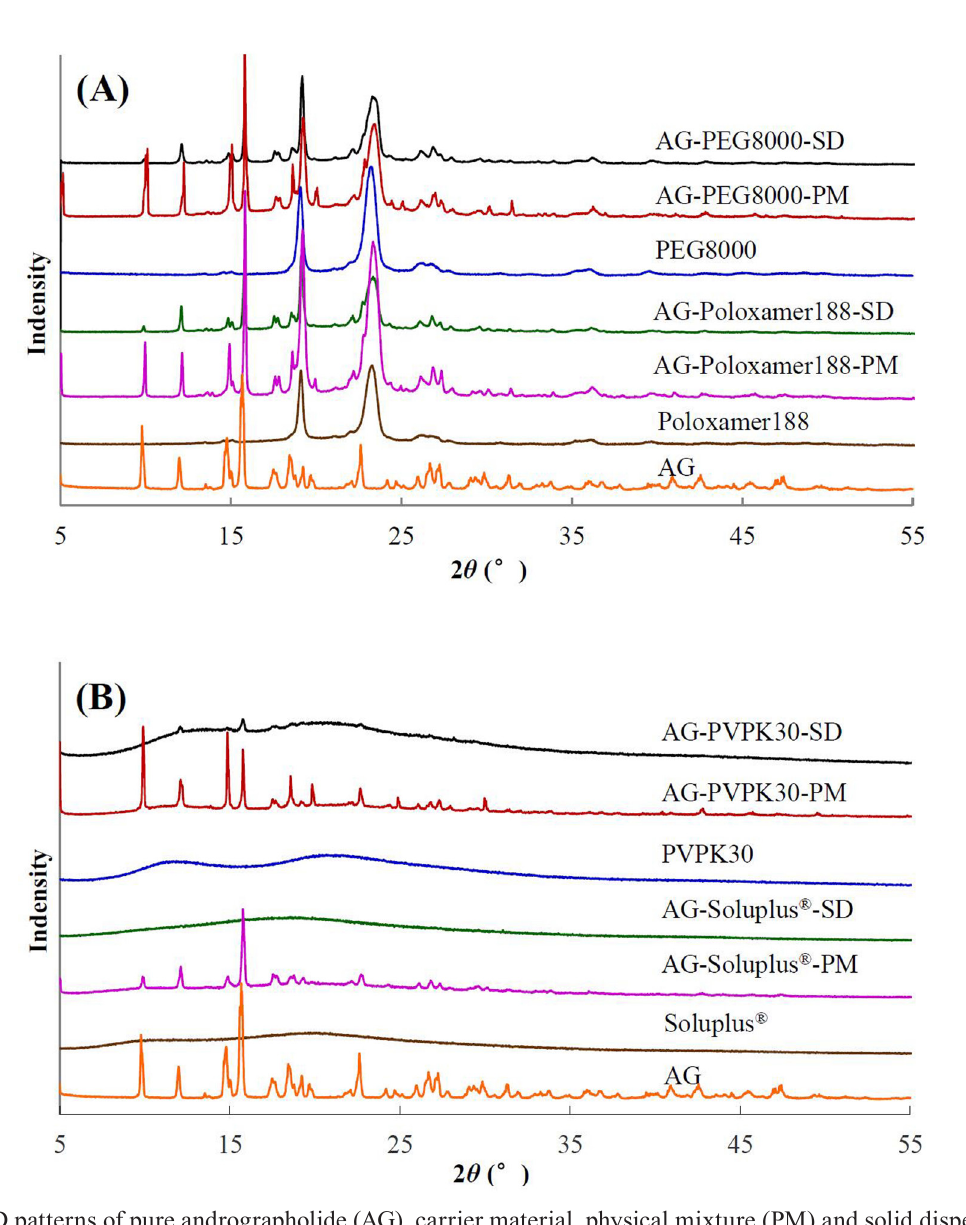
FIGURE 4 - XRD patterns of pure andrographolide (AG), carrier material, physical mixture (PM) and solid dispersion (SD) (A) PEG8000 and Poloxamer188 as carrier materials, (B) PVPK30 and Soluplus ® as carrier